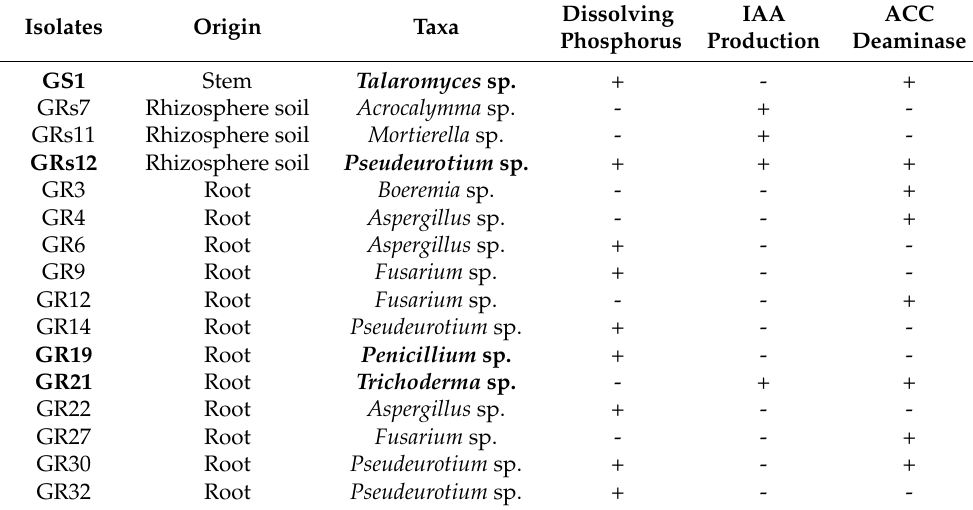
GR32 Root Pseudeurotium